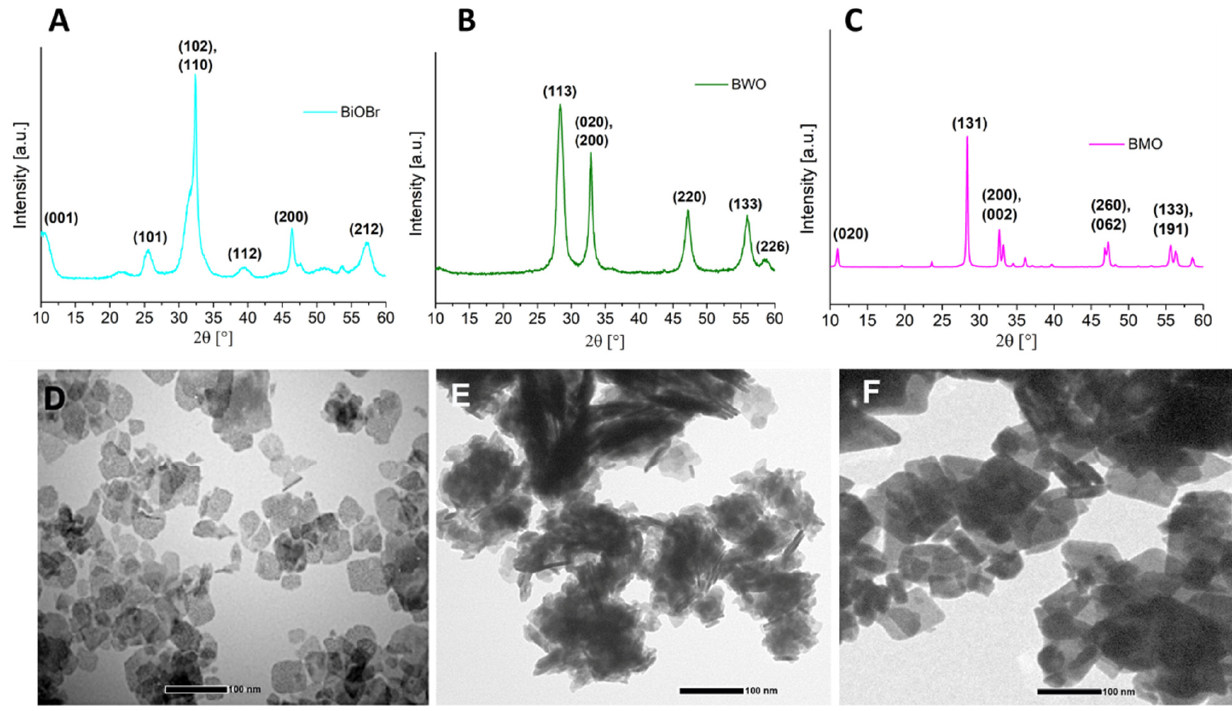
Figure 1. X-ray diffraction (XRD) of ( A ) BiOBr; ( B ) BWO and ( C ) BMO; transmission electron microscopy (TEM) images of ( D ) BiOBr, ( E ) BWO, and ( F ) BMO.